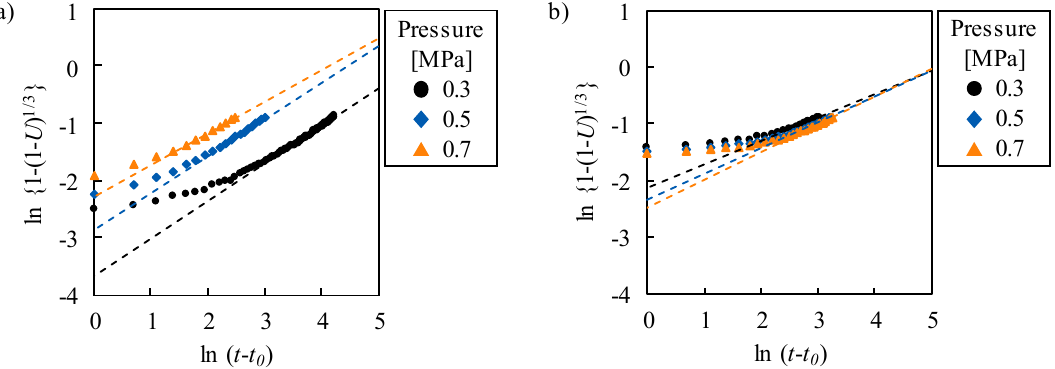
Figure 4. Relationship between swelling / shrinkage completion ratio and time during ( a ) absorption and ( b ) discharge. The dashed lines represent approximate straight lines at U > 0.5.